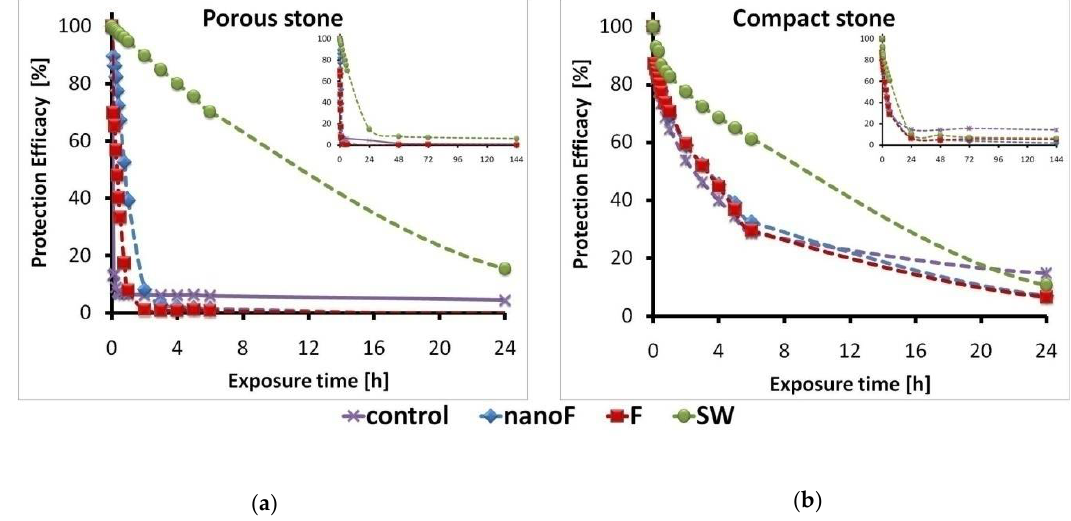
Figure 6. Protection efficacy (PE) against capillary water absorption as a function of exposure time measured after the pancreatin test on: ( a ) porous stone; ( b ) compact stone. The protection efficacy up to 6 days of exposure is reported in the inset boxes.